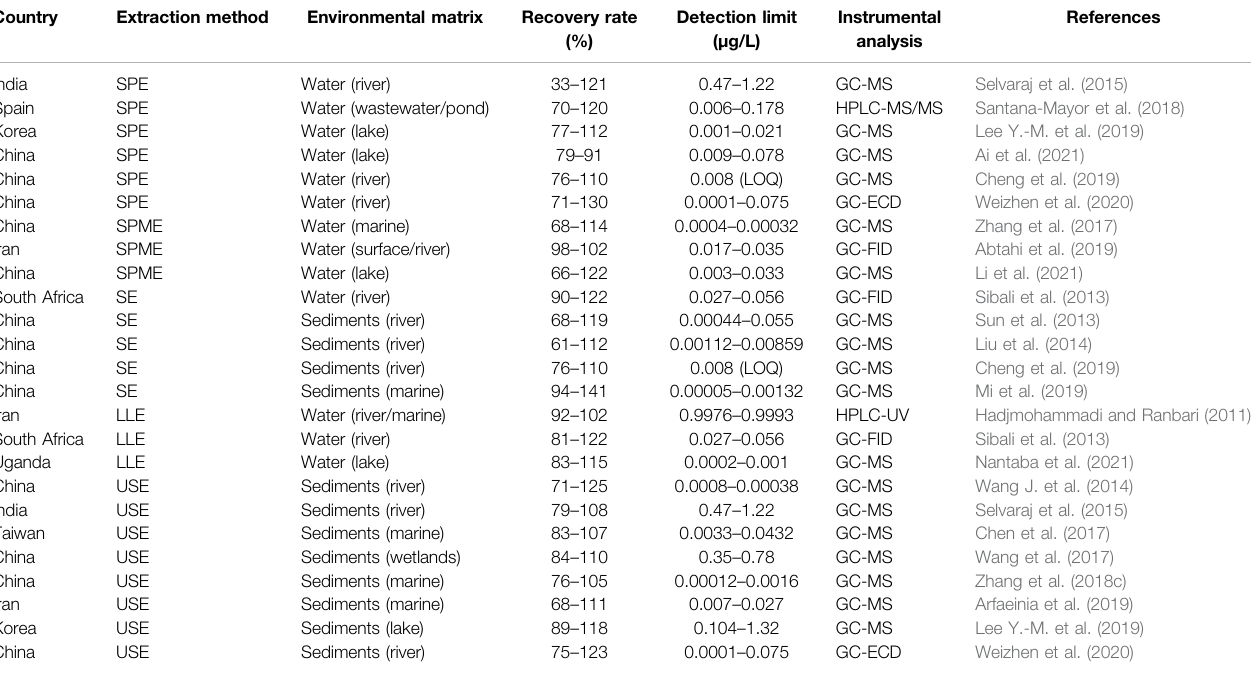
TABLE 6 | Some of the recent extraction and analysis methods applied on environmental matrices.